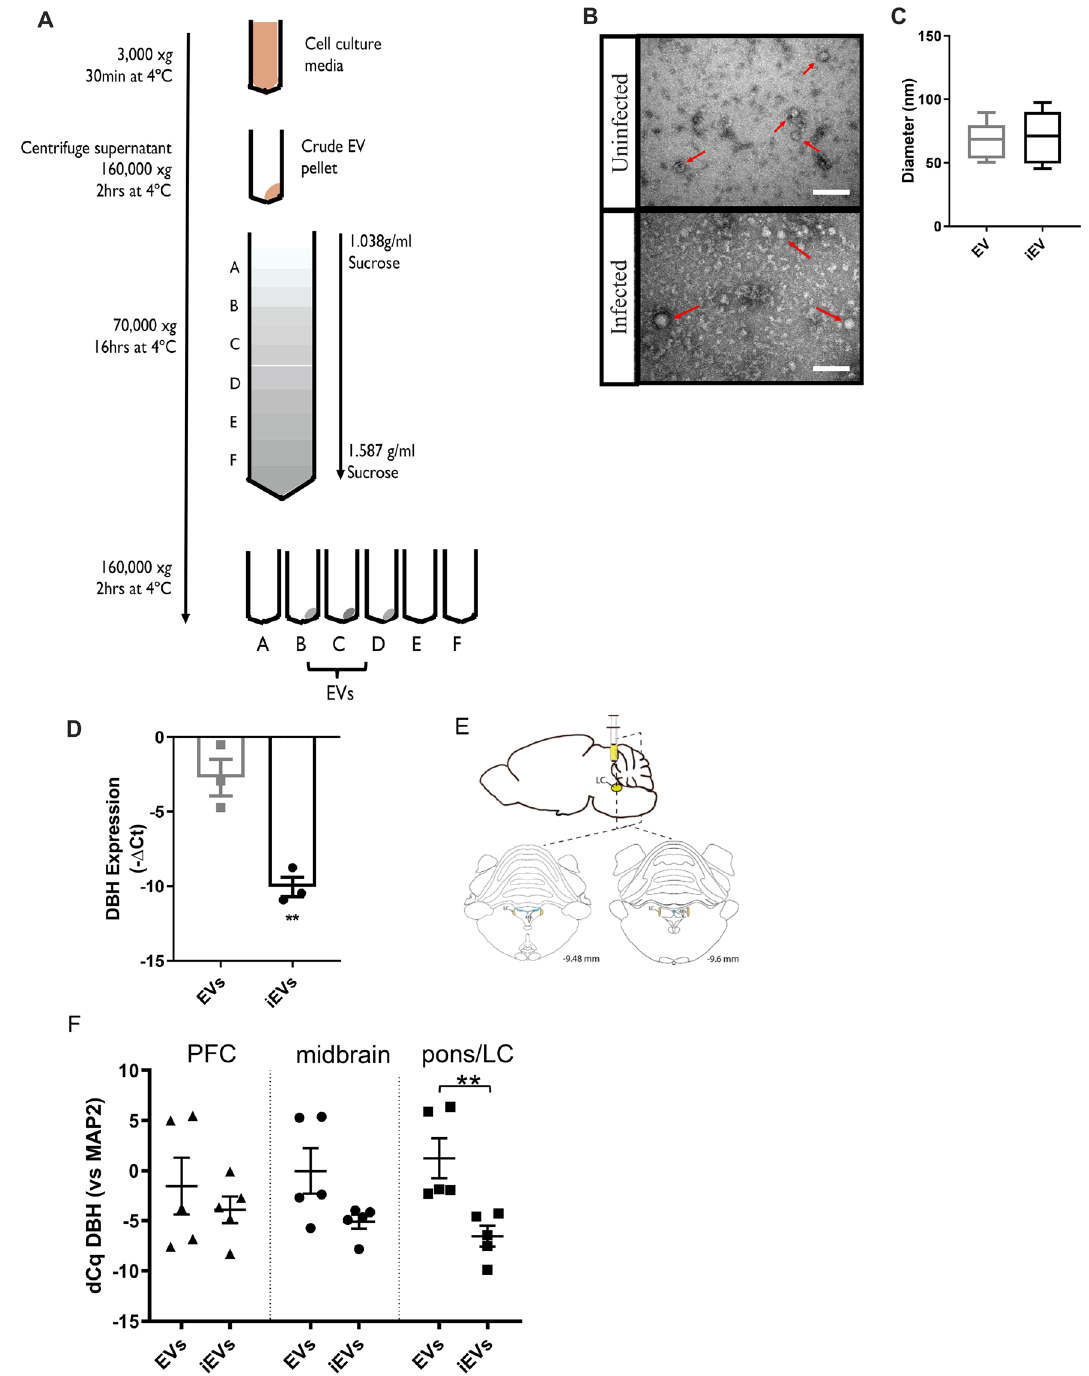
Figure 1. Toxoplasma-induced neuronal extracellular vesicles (TINEV) induce transcriptional regulation in neuronal cells. (A) Scheme summarising sequential ultracentrifugation steps undertaken to produce purified extracellular vesicles. Sucrose gradient densities range from 0.104 to 1.43 g/ml. The density between 1.15 and 1.19 g/ml was collected as this represents extracellular vesicles 80 . (B) Transmission electron microscopy of extracellular vesicles isolated from uninfected (top) and infected (bottom) PC12 cell cultures. Arrows indicate extracellular vesicles; scale bar represents 100 nm. (C) Plot of extracellular vesicle diameter from uninfected (EV) and T. gondii infected PC12 cultures (iEV); p = 0.81 (D) DBH mRNA expression following treatment with purified TINEVs. PC12 cells were treated with EVs from uninfected (grey) and T. gondii -infected (black) cultures for 24 h; n = 3, ** p = 0.006. Graphs show ± SEM with p values for Student’s t tests. (E) A schematic representation of experimental design illustrating the site of injection for delivery of EVs directly into the brain’s noradrenergic center, the locus coeruleus (LC), of rats. Brain regions (prefrontal cortex, midbrain, and the pons/LC as illustrated by the dotted lines) were harvested two days following 3 days of twice daily treatment. RNA was purified from tissues and RT-qPCR performed to quantitate DBH expression. Stereotaxic coordinates from Paxinos and Watson 81 . (F) DBH mRNA levels in brain tissues of rats receiving TINEVs (iEVs) and uninfected cell EVs, relative to the neuronal marker MAP2. The pons containing locus coeruleus (pons/LC) contained significantly down-regulated DBH . ± SEM shown, n = 5, Mann–Whitney unpaired t test, ** p =